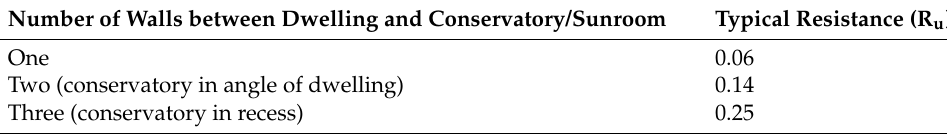
Table 4. Typical R u values for conservatory-type sunroom (adapted from